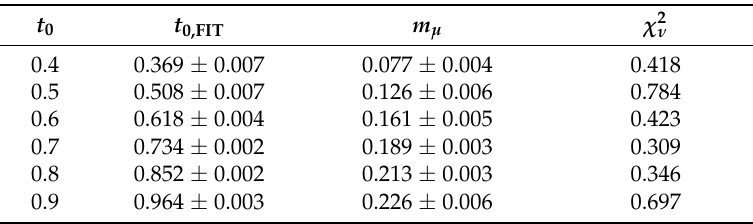
Table 2. Values of the fitting parameters t 0,FIT and m µ of the noise reduction factor as a function of σ 0 for (cid:104) m (cid:105) = 2.23 and η = 0.145 in the case of log-normal distributions of t . In the last column the χ 2 per degree of freedom is